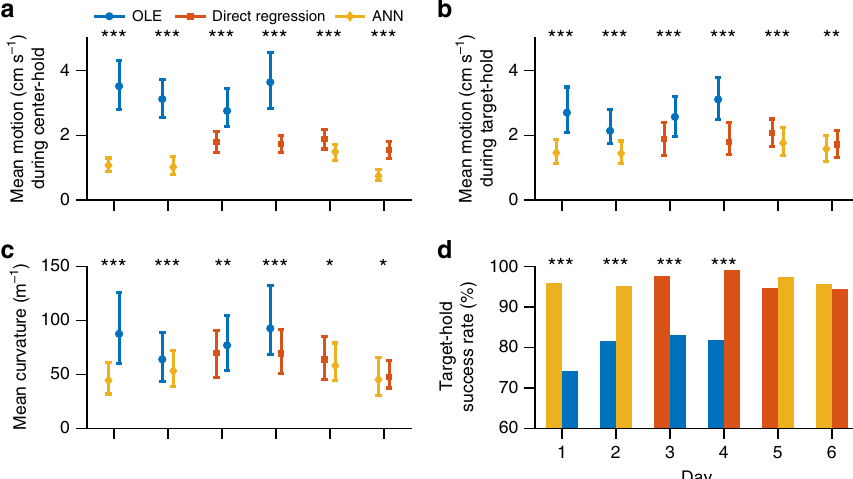
Fig. 9 Comparison of BCI performance between within-day decoder pairs. For each day, the decoder that was run fi rst is on the left, and the second on the right. Asterisks represent signi fi cance level of statistical tests between decoders: * p < 0.05, ** p < 0.01, *** p < 0.001 (single-sided Mann – Whitney U -test for a , b and c ; chi-square test for d ). On day 2 – 4, center-hold duration was shortened to be between 200 and 300 ms for OLE. The reference speed s 0 used for decoder calibration (see Methods) was lowered to 80% for OLE on day 2 – 3. Task parameters of each session, including the number of trials per target, could be found in Supplementary Table 2. a Mean rate of motion during center-hold before movement onset. The marker (blue circle for OLE, orange square for Direct Regression, and yellow diamond for hANN) represents the median value across all trials, and “ whiskers ” represent the 25 and 75 percentile values (same in b and c ). b Mean rate of motion during target-hold after movement offset. c Mean curvature of cursor trajectory between movement onset and movement offset. d Percentage of successful target-hold periods of the trials in which the target was